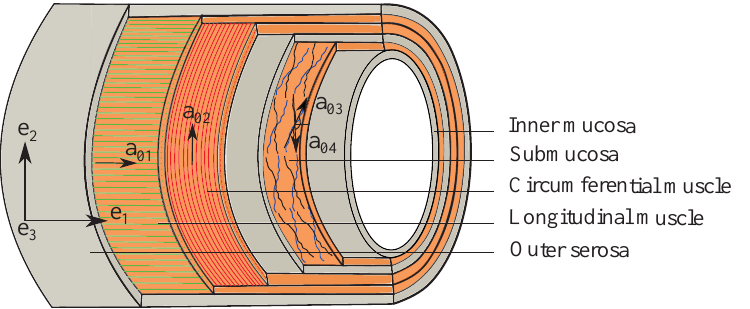
Figure 2. Schema of the multilayer colon showing collagen fiber orientations in the longitudinal muscular ( a 01 ), the circumferential muscular ( a 02 ) and the submucosal ( a 03 , a 04 ) layers with respect to the Cartesian coordinate system ( e 1 , e 2 , e 3